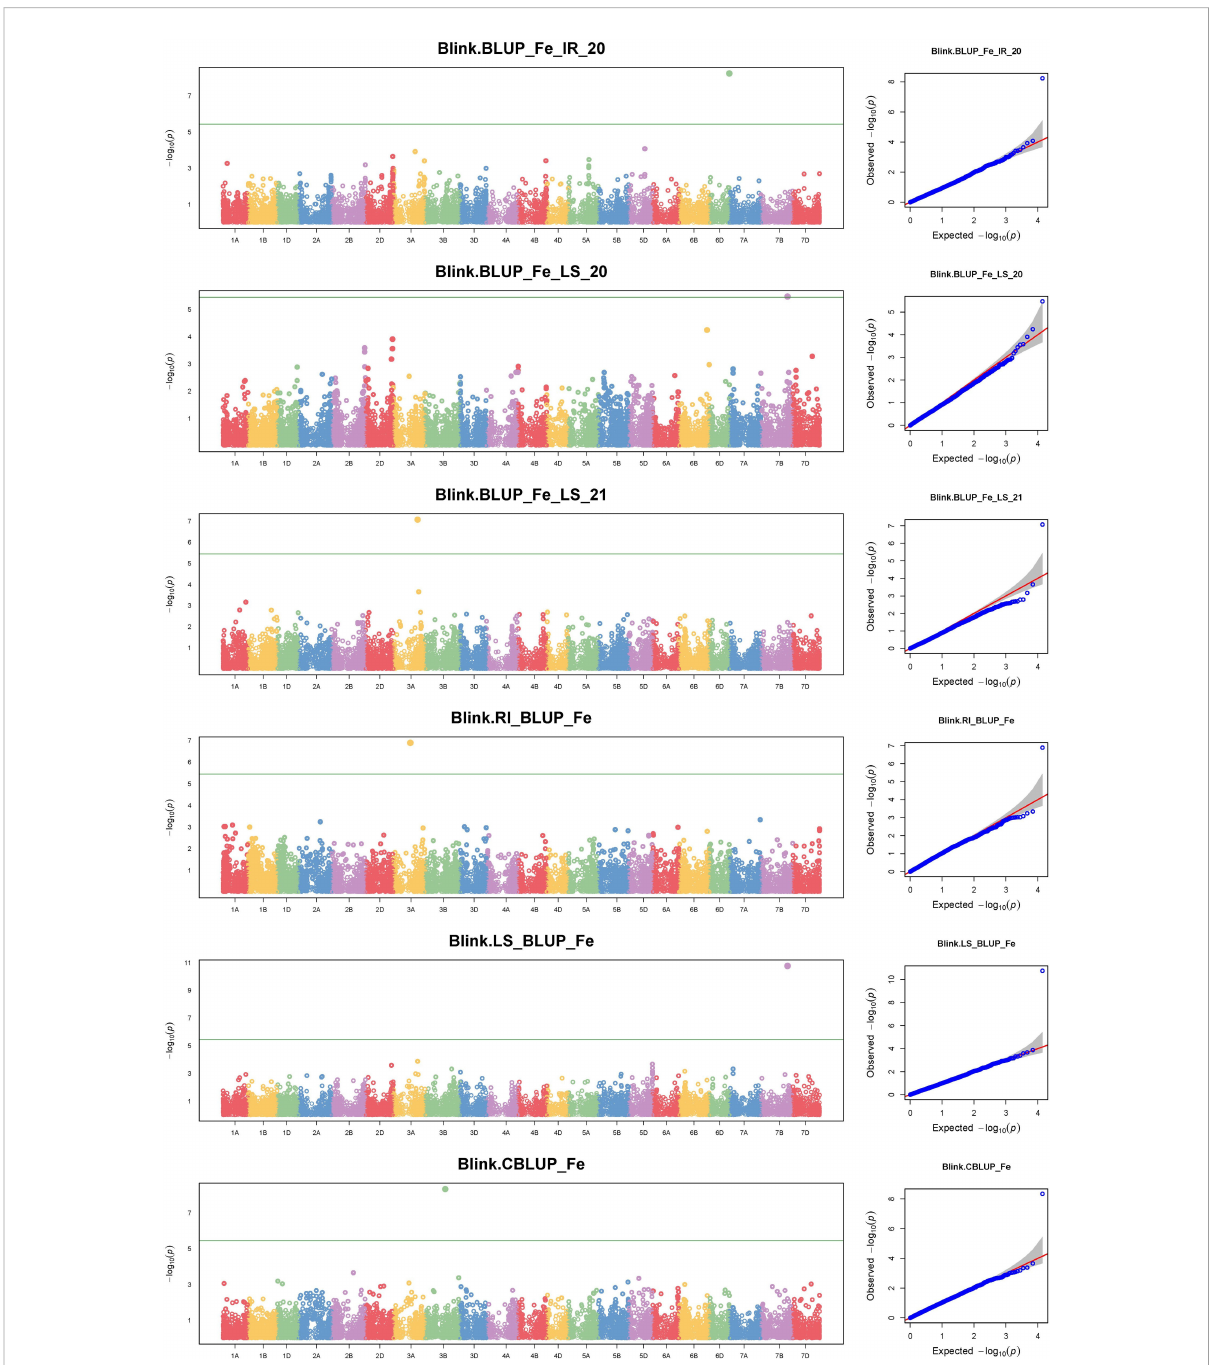
FIGURE 7 Manhattan and respective quantile – quantile (Q – Q) plots of signi fi cant associations for GFeC under IR, RI, LS, and combined